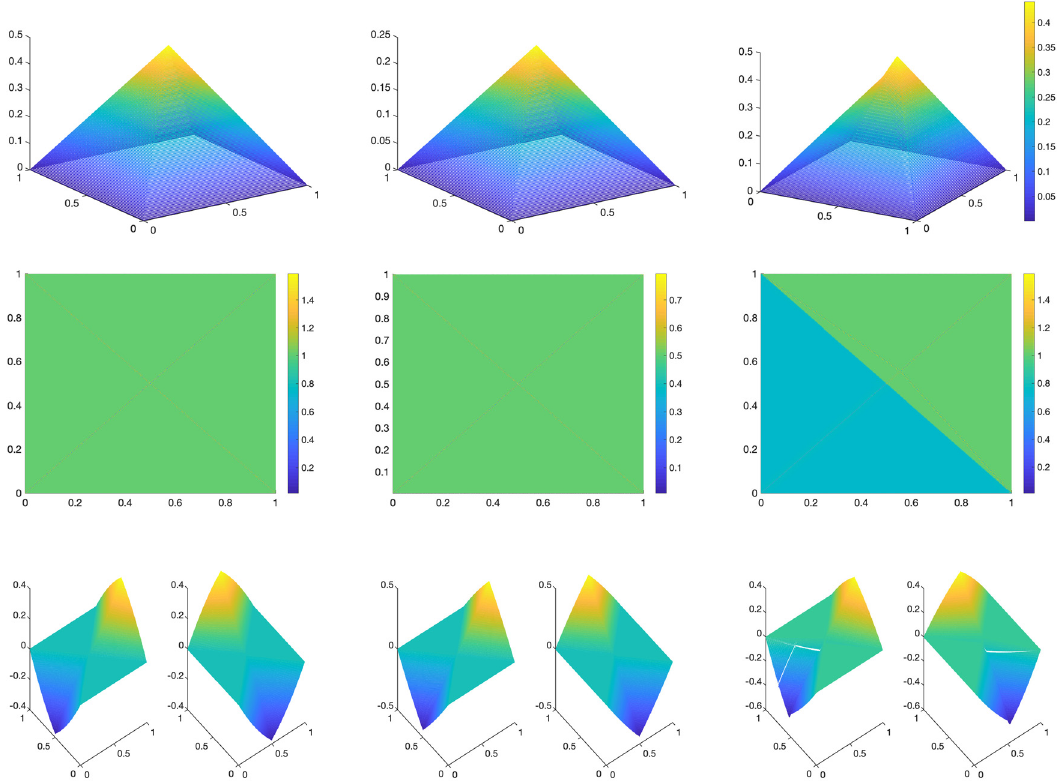
. The fi rst two columns represent constant α 1 = h